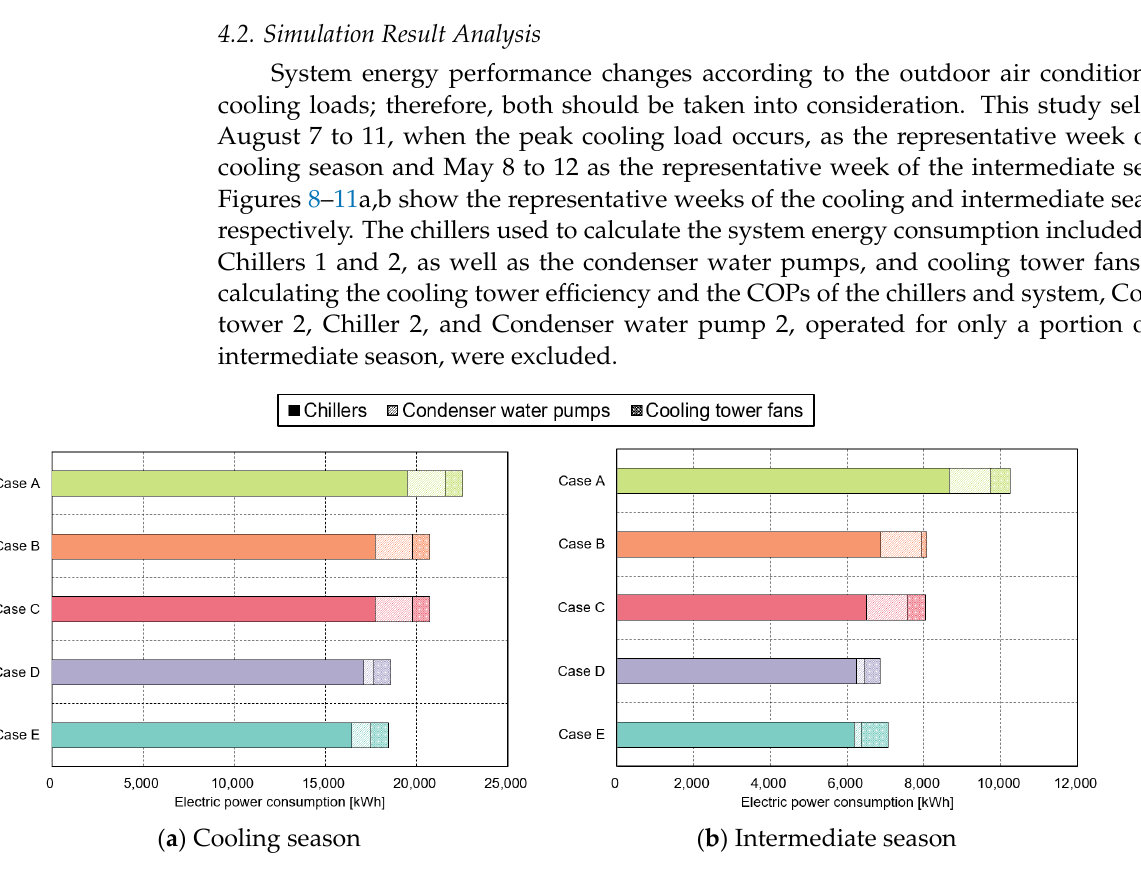
Figure 10. Weekly system energy consumption for Case